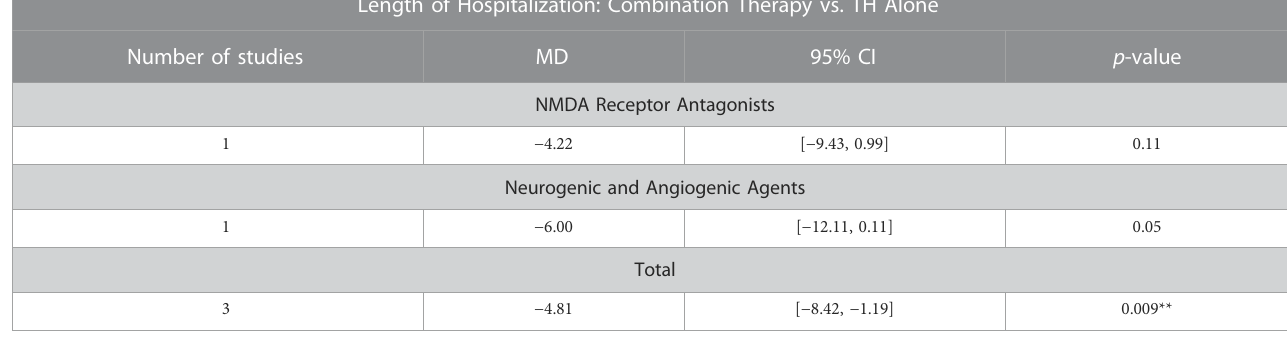
TABLE 3 ( Continued ) Summary of fi ndings table for outcomes assessed. Effect sizes [odds ratio (OR): mortality, NDI; mean difference (MD): length of hospitalization], 95% con fi dence intervals (95% CI) and two-tailed p